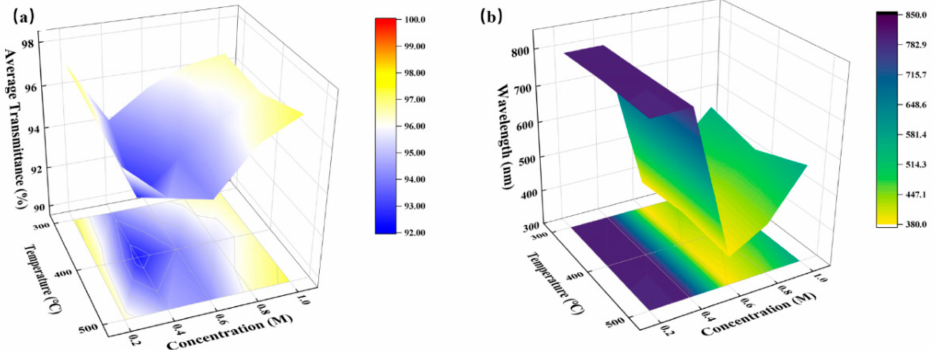
Figure 8. ZYAMO thin films with different concentrations after different temperature annealing. ( a ) Average transmittance in the visible region. ( b ) Maximal transmittance to wavelength in the visible region.